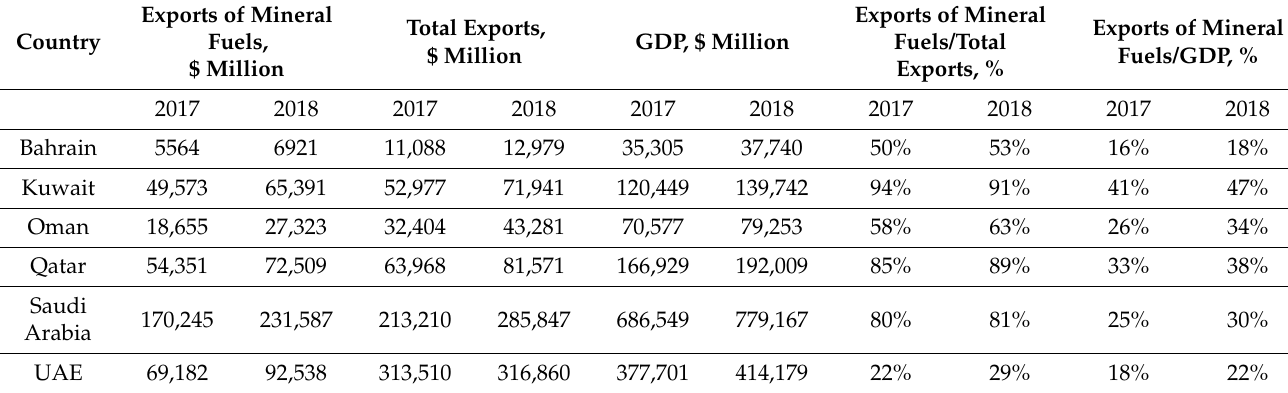
Table 2. Contribution of exports of mineral fuels * to total exports and GDP for GCC countries. Exports of Mineral Country